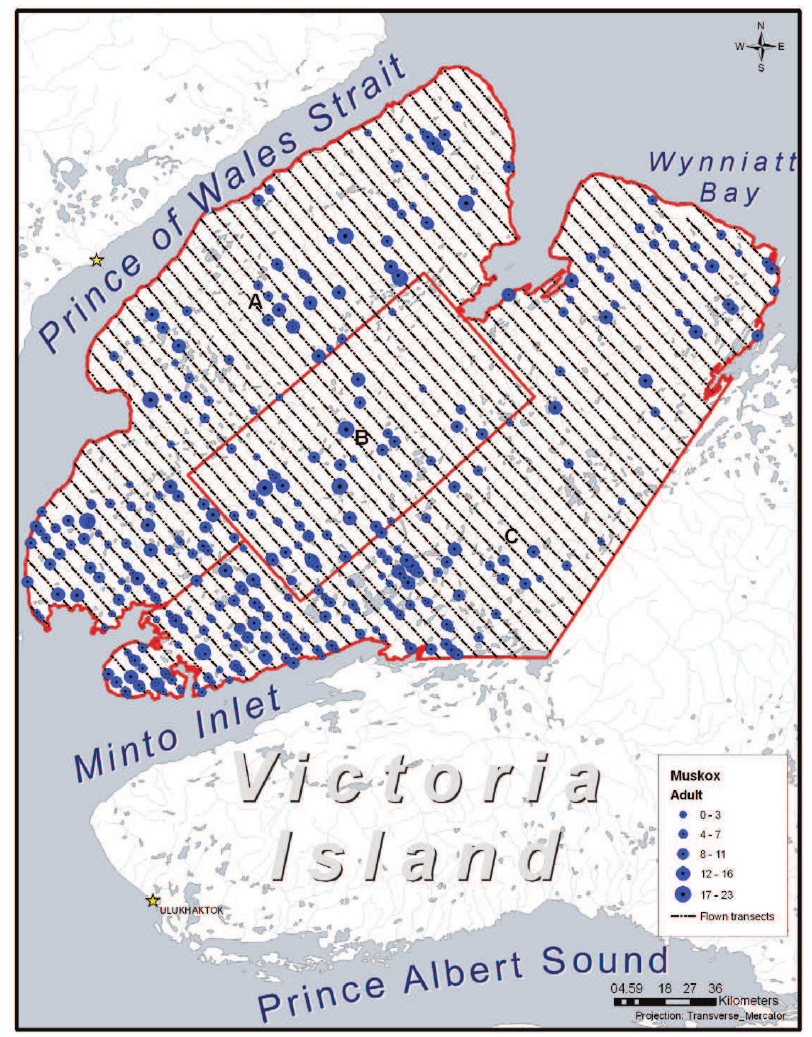
Fig. 4. Transects flown during the 2010 survey and distribution of adult mus- koxen found ‘on’ transect on northwest Victoria Island, NWT.